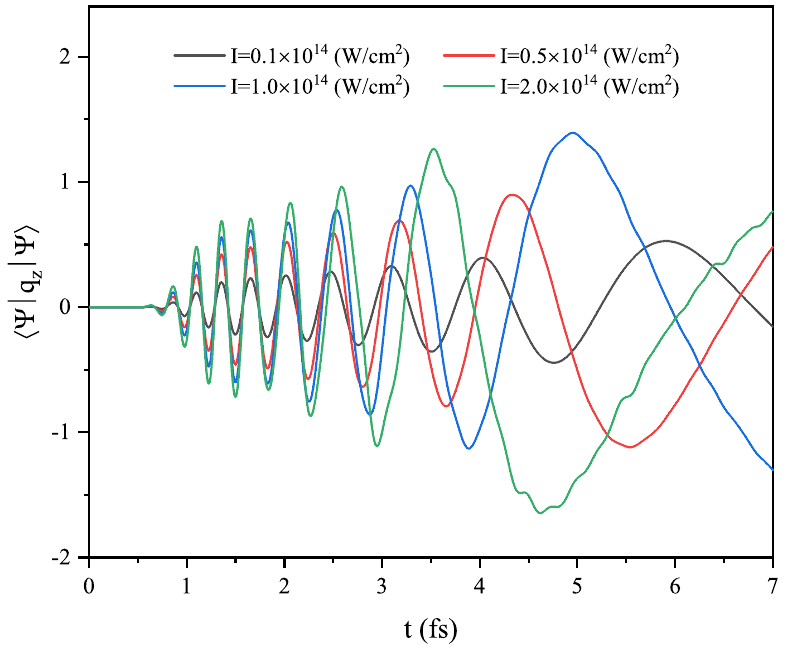
Figure 5. Expectation value of the location of the single electron in a laser-induced H + Ultra-short intense laser fields (with four different intensities) strike the ground state of the system at a specific